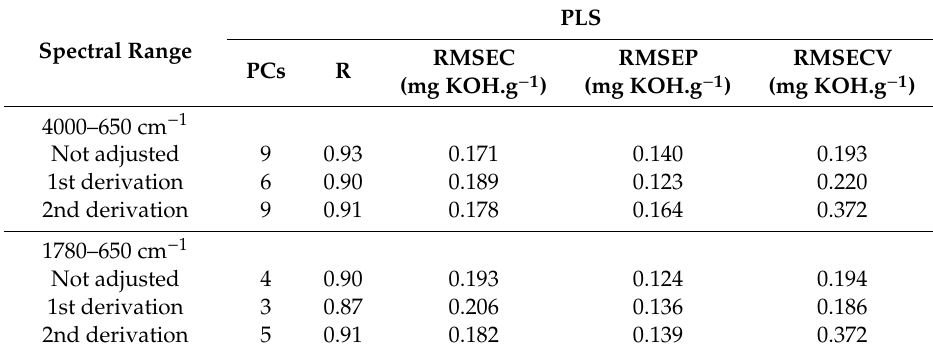
Table 1. Results of calibration and validation of determination of the TBN using the FTIR-PLS regression in di ff erent spectral